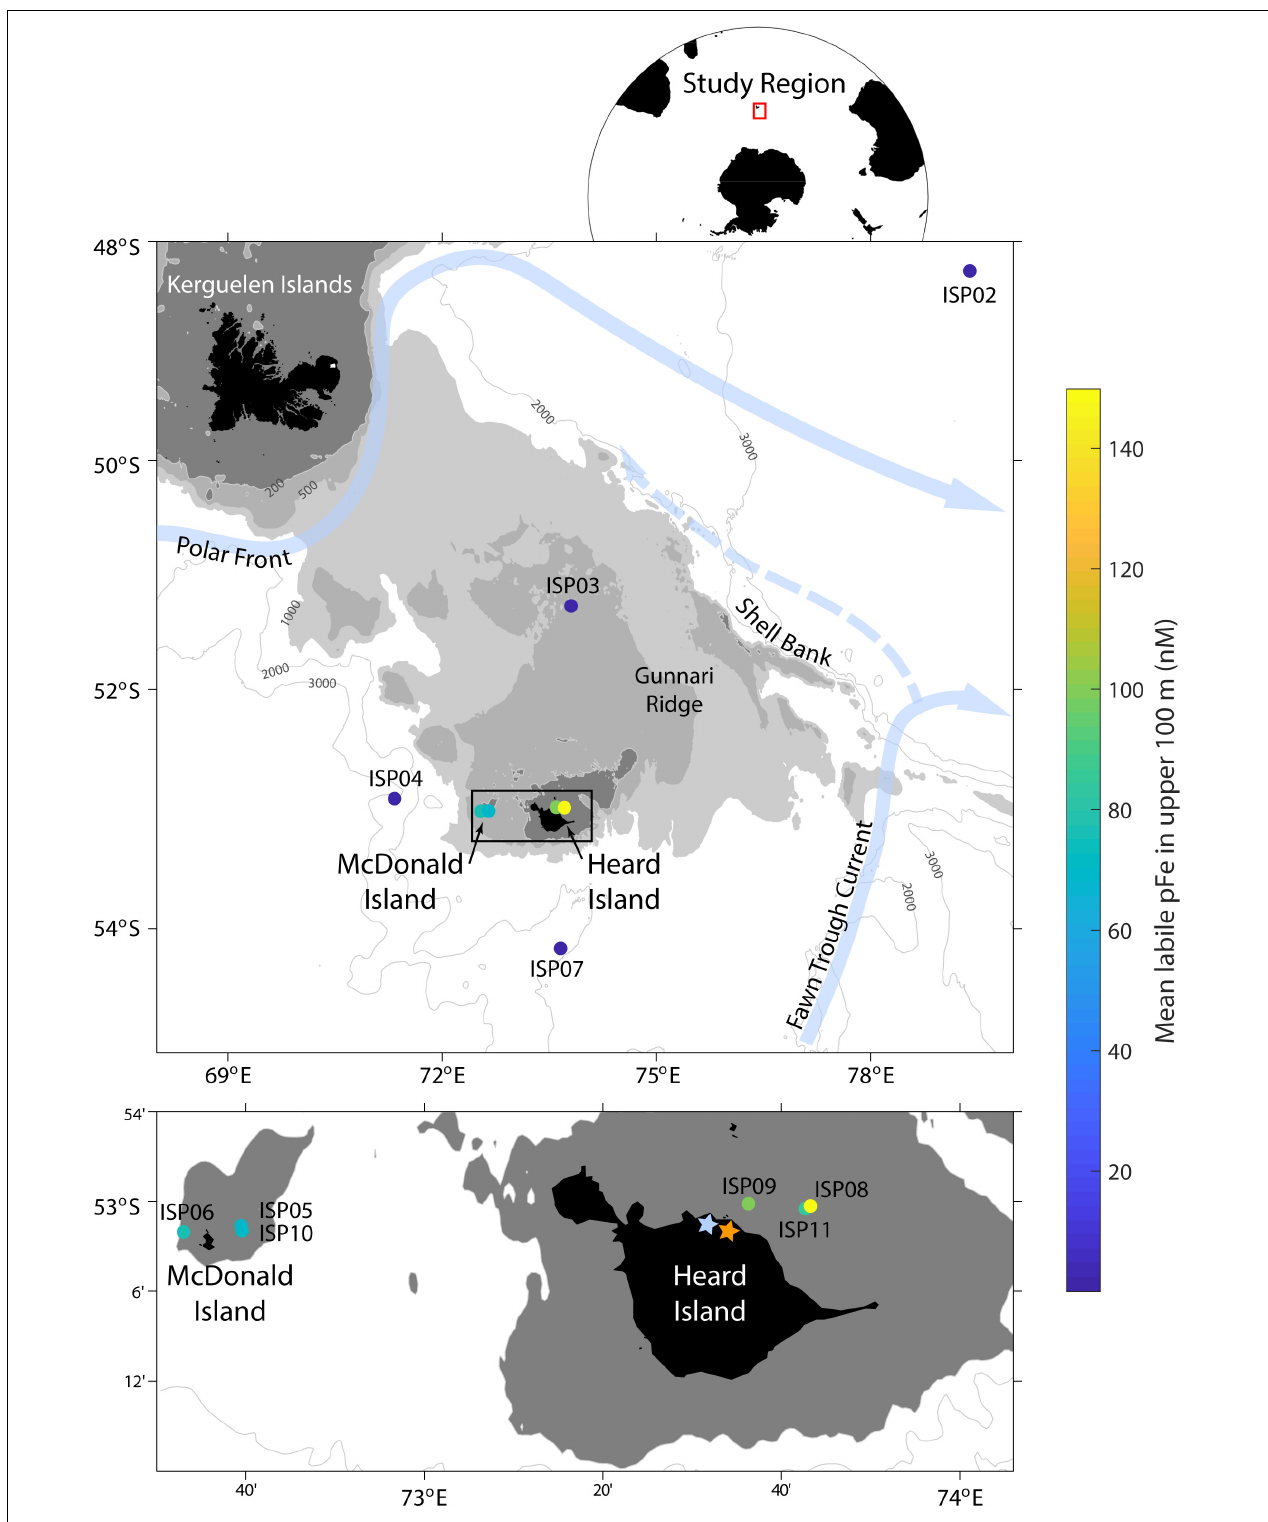
FIGURE 1 | Map of the study region during the Heard Earth-Ocean-Biosphere Interactions (HEOBI) cruise in January and February 2016. The mean concentration of labile particulate Fe (pFe lab ) in the upper 100 m at each station is indicated with a colour scale and main surface currents in light blue. Downes (blue star) and Ealey (orange star) marine terminating glaciers are also indicated on Heard Island. The low-Fe, reference stations were ISP2 and 7, the moderate-Fe plateau stations were ISP3 and 4, while our high-Fe near-shore stations were ISP5, 6, and 10 (McDonald Island) and ISP8, 9, and 11 (Heard Island).